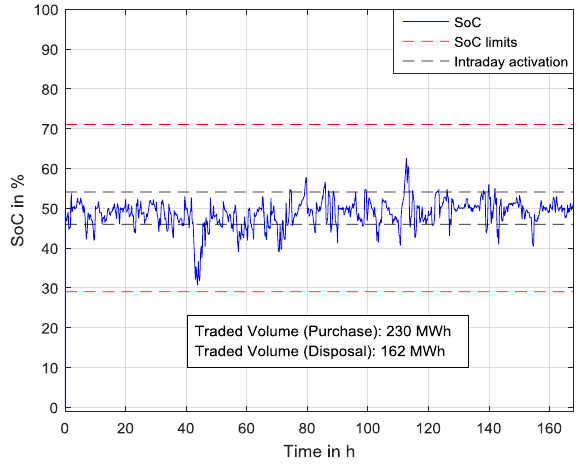
Figure 7. SoC characteristics for using all DoFs.